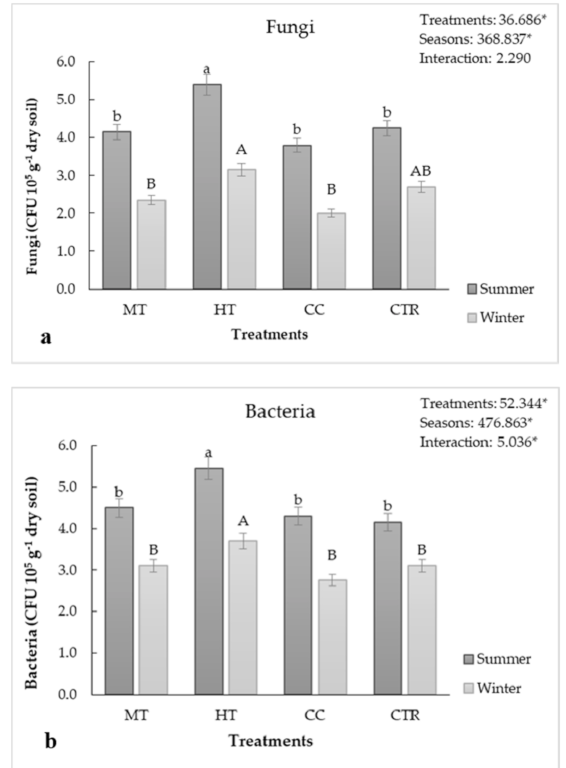
Figure 2. ( a ) Fungi (CFU 10 4 g − 1 dry soil) and ( b ) bacteria (CFU 10 5 g − 1 dry soil) in soil under differently managed plots of a Pinus laricio plantation in summer and winter. HT: intensive thinning; MT: moderate thinning; CC: clear cut; and CTR: control. Two-way ANOVA shows the effects of treatments, seasons, and their interactions. Lowercase letters and capital letters show significant differences among the management intensities (Tukey’s test, p -level ≤ 0.05) in summer and winter, respectively. The data are the means of two consecutive years (2014 and 2015). CFU: colony forming units. * p < 0.05. Different letters show significant differences at p ≤